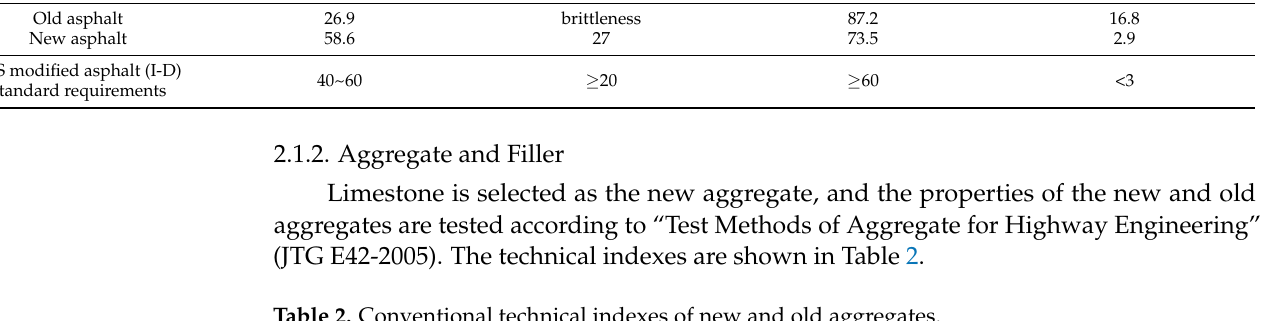
Table 2. Conventional technical indexes of new and old aggregates.